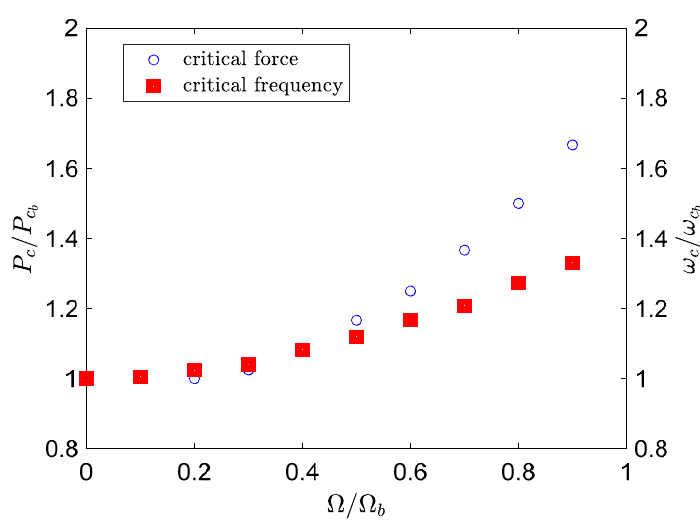
Figure 5. The effect of rotating speed on the critical compressive force and instability frequency for θ = 0 ◦ .